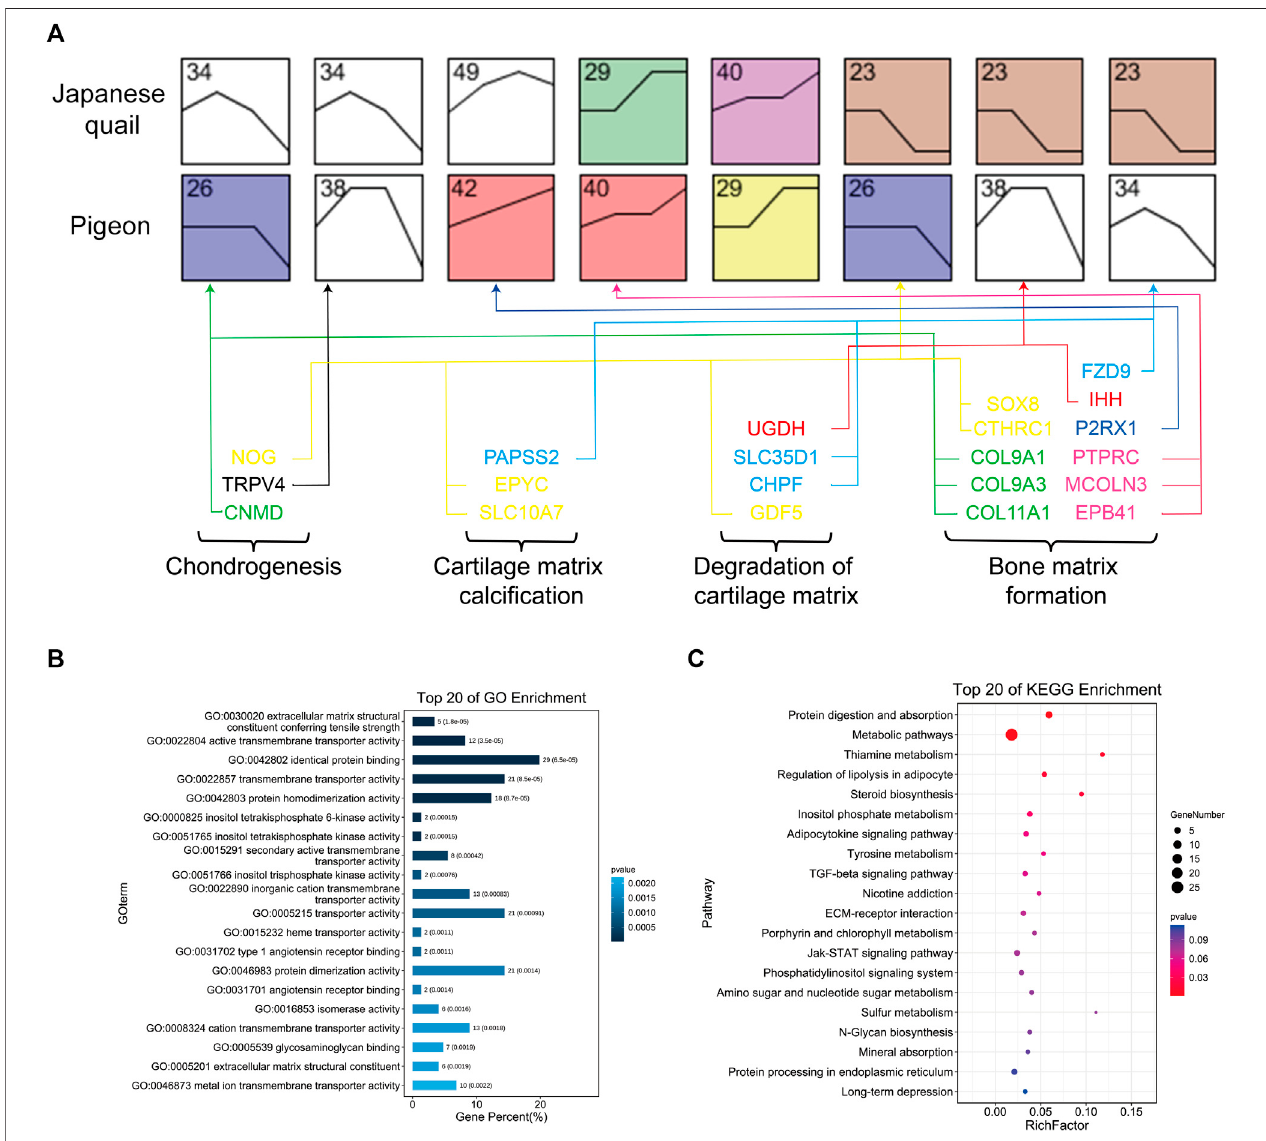
FIGURE 4 | Gene expression pattern analysis of quail and pigeon. (A) Expression pro fi le pairs for comparison between quail and pigeons. The number represents thenumber oftheexpression pro fi le.ThefourdevelopmentalstagesfromlefttorightareE12(E14),E15(E17),D1,andD14ofquail(pigeon).Theverticalaxis represents thegeneexpressionlevel.Coloredboxesindicatethatthe p -valueislessthan0.05. (B) GOenrichmentofgenesobtainedfromthecomparisonofexpressionpro fi les. (C) KEGG pathway enrichment of genes obtained from the comparison of expression pro fi les.